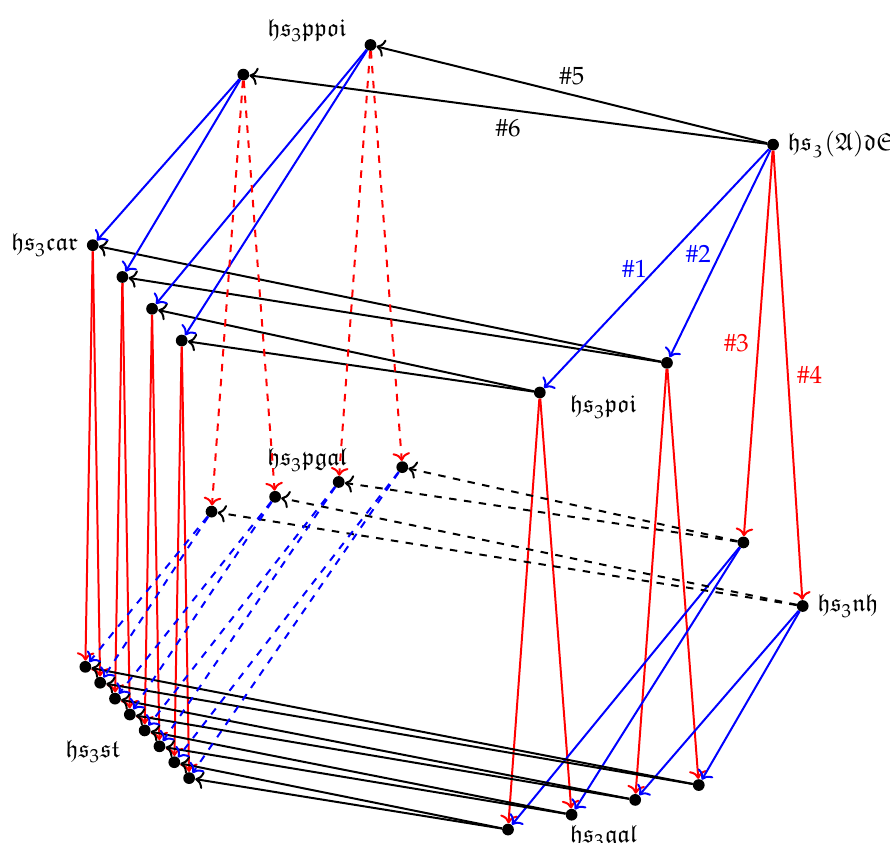
Figure 3. This figure [185] summarizes the contractions of Table 3. There are 2 space-time (blue; #1,#2), 2 speed-space (red; #3,#4) and 2 speed-time (black; #5,#6) contractions, and combining them leads to the full cube. The explicit commutators of all algebras can be found in the Appendix of [185]. In comparison to Figure 1, we have for clarity omitted the double